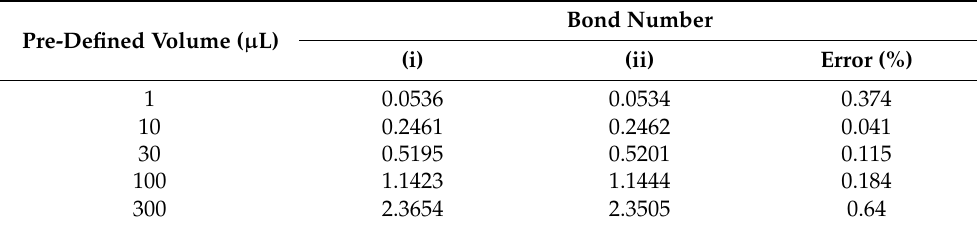
Table 3. Comparison of Bond number between (i) Young–Laplace theoretical droplet and (ii) gener- ated droplet using the elliptic model.